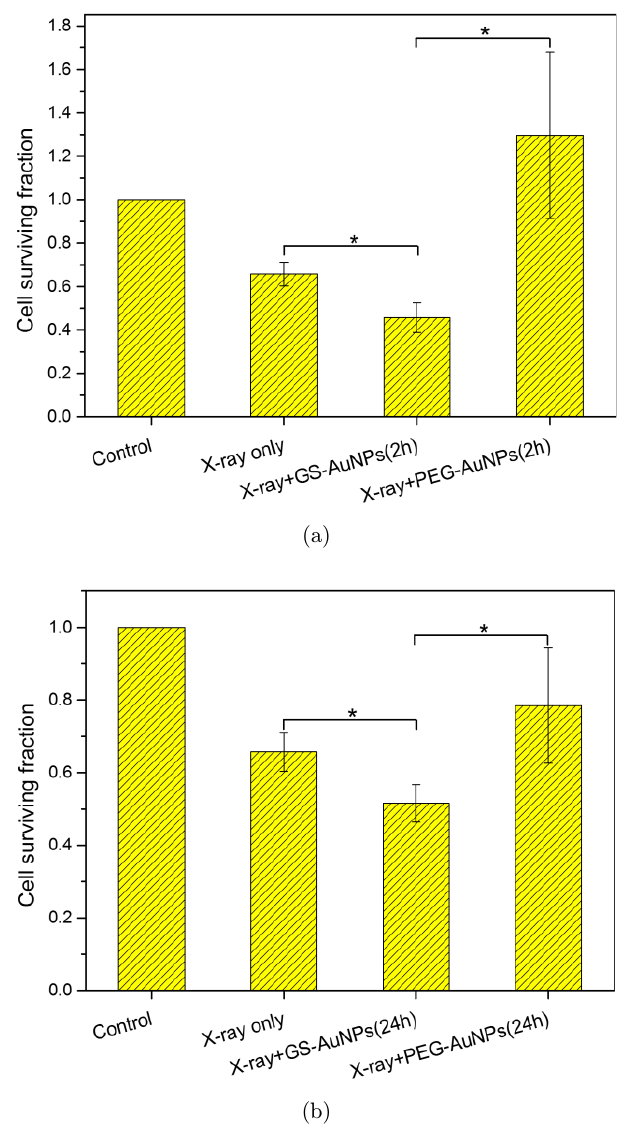
Fig. 3. In vitro radiosensitization e®ect of GS-AuNPs and PEG-AuNPs after 2 h incubation, (a) and 24 h incubation, (b) X-ray dose is 2.25 Gy for both studies. (cid:5) P < 0 : 05 by two- sample t -test.